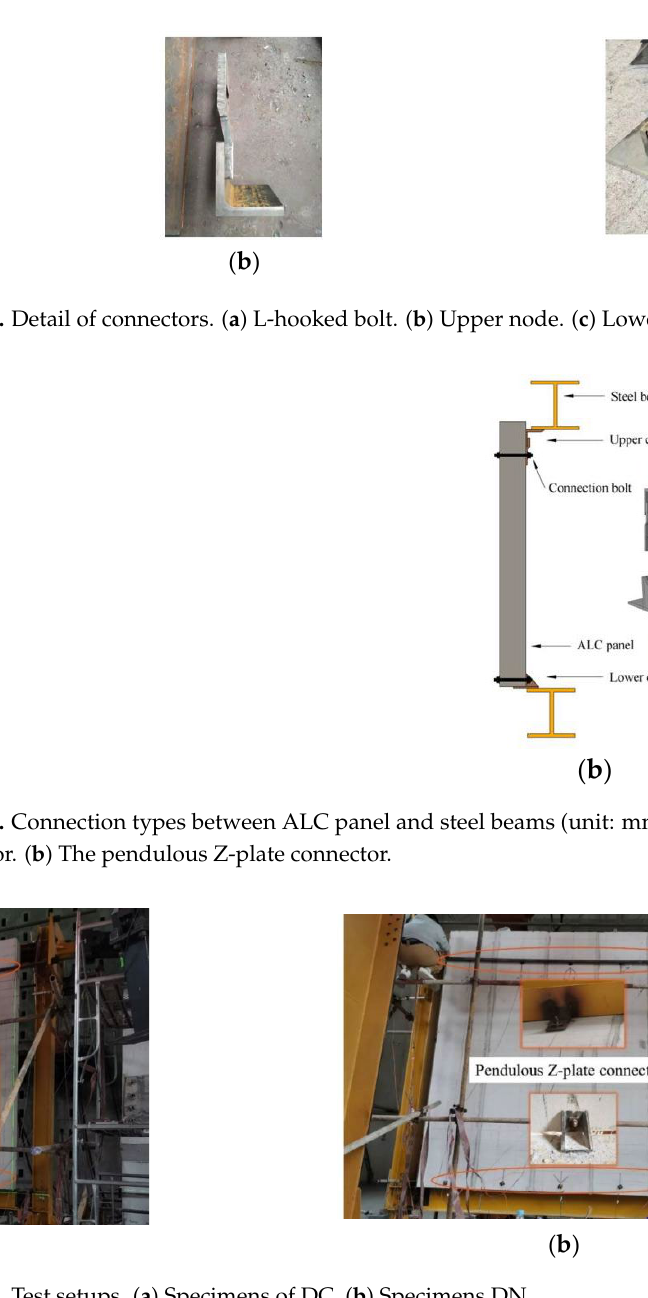
Figure 2. Dimensions of specimens (unit: mm).